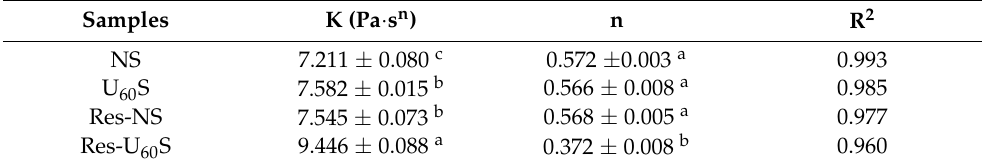
Figure 3. Flow curves ( A ) , storage modulus (G′, ( B ) ), loss modulus (G″, ( C ) ), and tan δ ( D ) of starch samples as a function of oscillation frequency. Table 2. Power-law parameters of starch